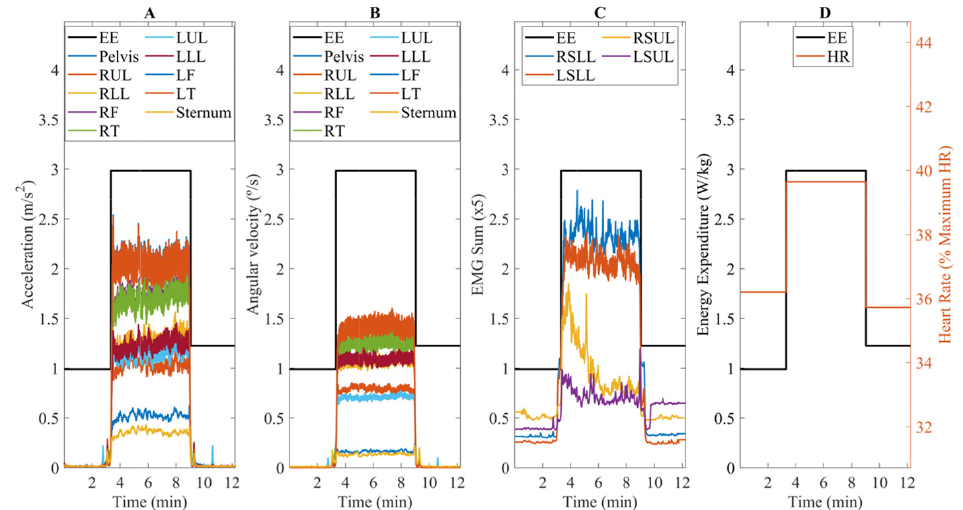
Figure 2. Example of post-processed data used to estimate the steady-state energy expenditure for one random participant: ( A ) acceleration; ( B ) angular velocity; ( C ) EMG sum; and ( D ) HR. EE stands for Energy Expenditure, (R/L)LL for Right/Left Lower Leg, (R/L)UL for Right/Left Upper Leg, (R/L)SLL for Right/Left Sum Lower Leg, and (R/L)SUL for Right/Left Sum Upper Leg.